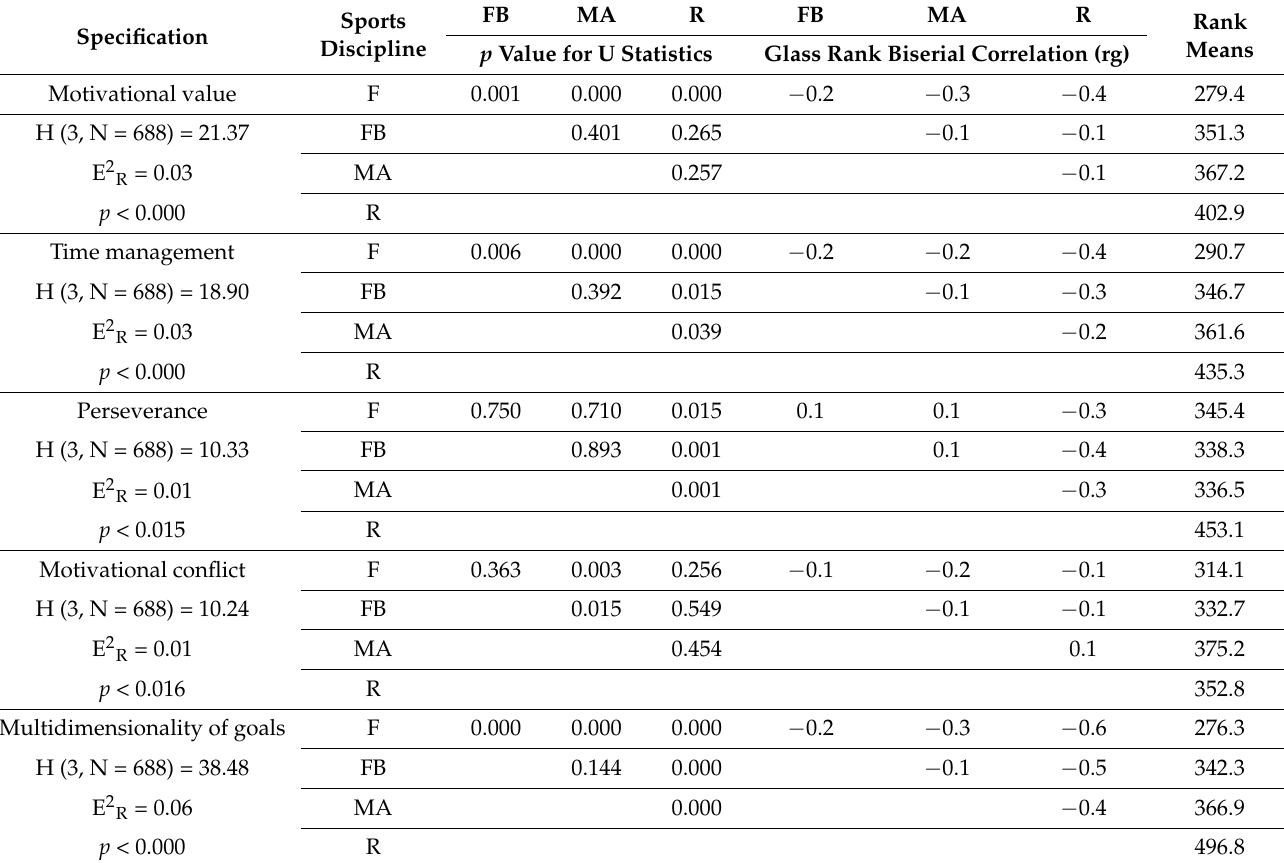
Table 3. Motivational role of physical activity goals (IPAO), depending on the sport discipline (H test, E 2 R, U test, rg).